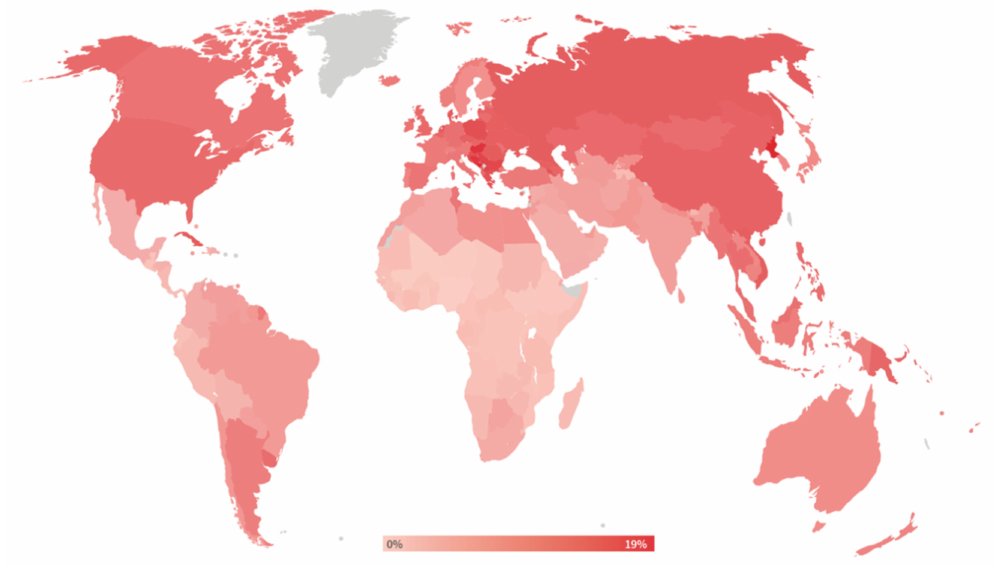
Figure 2. Percent of DALYs attributable to tobacco use. Reused from The Tobacco Atlas, 6th edition with permission. Copyright ©2018 The American Cancer Society, Inc.